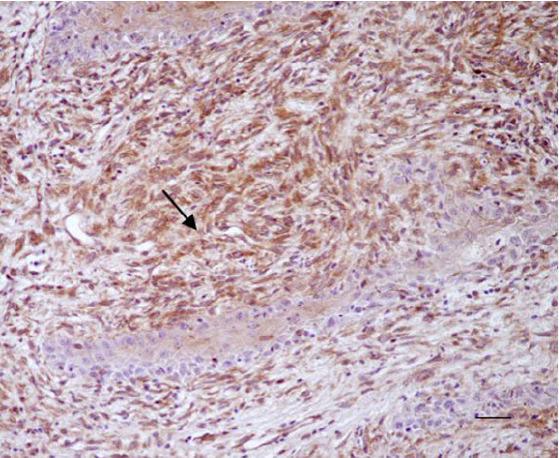
Figure 1. Equine sarcoid. Immunohistochemical staining. Neoplastic fibroblasts showed strong brown immunostaining for Beclin 1 (arrow) (20 × Scale bar: 100 µ m).